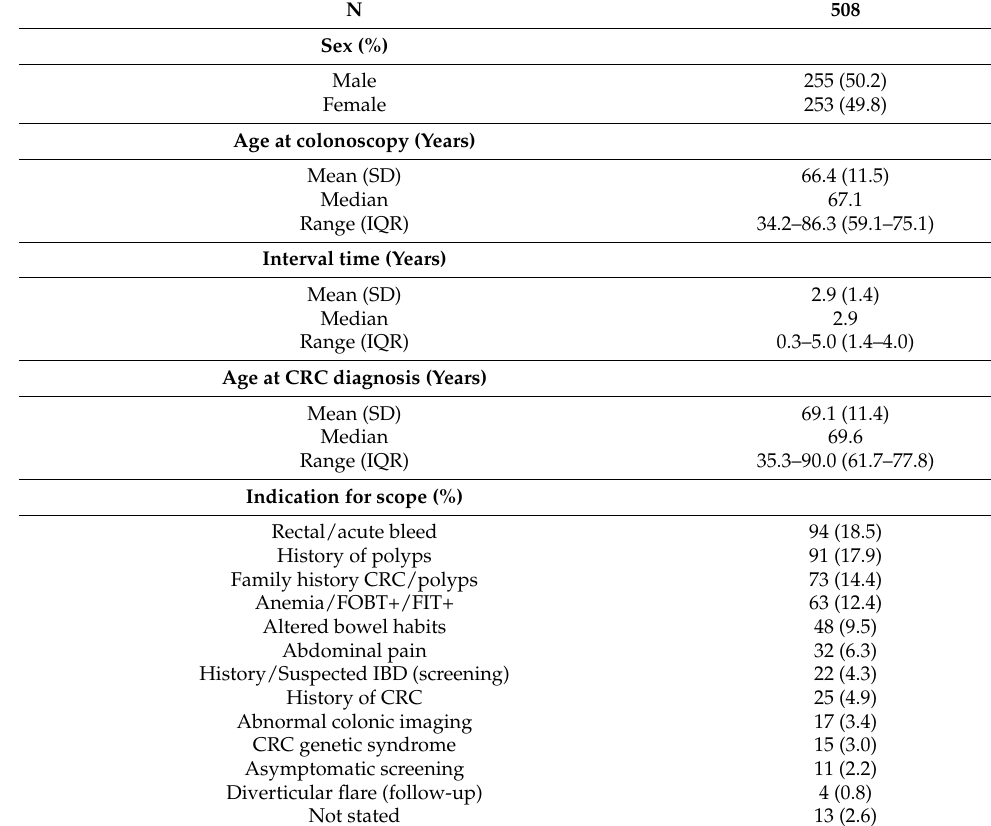
Table 1. Patient, endoscopy, and pathological characteristics of analyzed